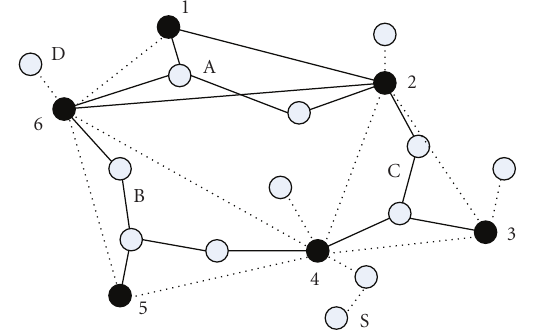
Figure 3: Example of position-based routing for wireless commu- nication networks [23].